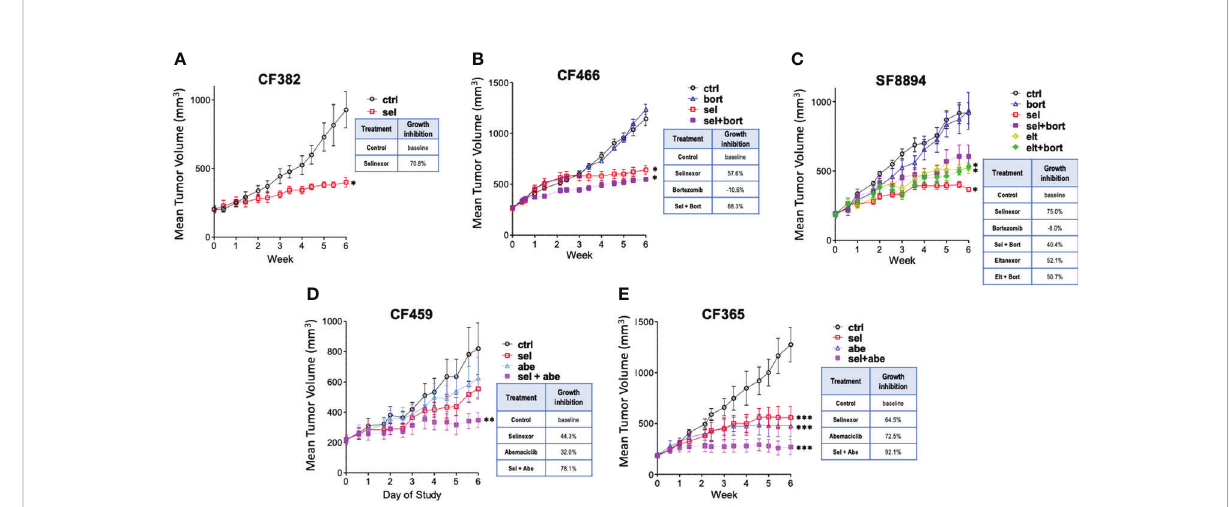
FIGURE 1 Selinexor inhibits chordoma growth in fi ve patient derived xenograft models. Tumor volume over time determined in (A) CF382; (B) CF466; (C) SF8944; (D) CF459; and (E) CF365 PDX models under untreated control, selinexor (sel), or eltanexor (elt) treatment either as single agents or in combination with bortezomib (bort) or abemaciclib (abe). Dosing: selinexor, 5 mg/kg, 4 times weekly, PO; eltanexor, 10 mg/kg; 5 times weekly, PO; bortezomib, 0.3 mg/kg, twice weekly, IV; abemaciclib, 50 mg/kg, daily, PO. Data are shown as mean +/- SEM. Relative percent change to control at termination of study is shown for each condition in inset tables. Signi fi cance determined using ANOVA with Bonferroni post-test comparing each experimental group to control. *p < 0.05; **p < 0.01; ***p <